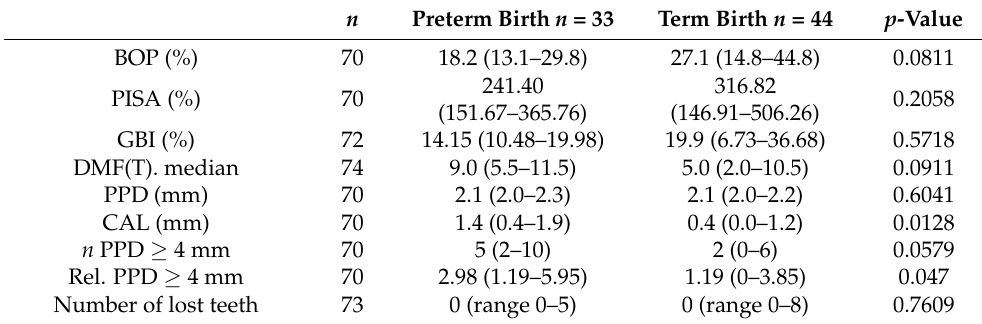
Table 2. Oral clinical data and labor data. Median with IQR.